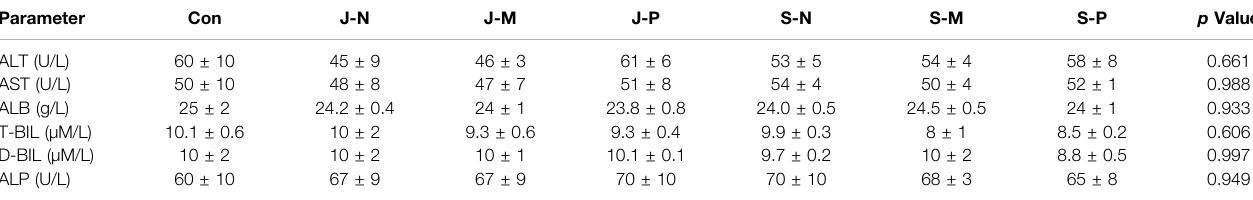
See Glossary , for de fi nitions of the parameters in the fi rst column.